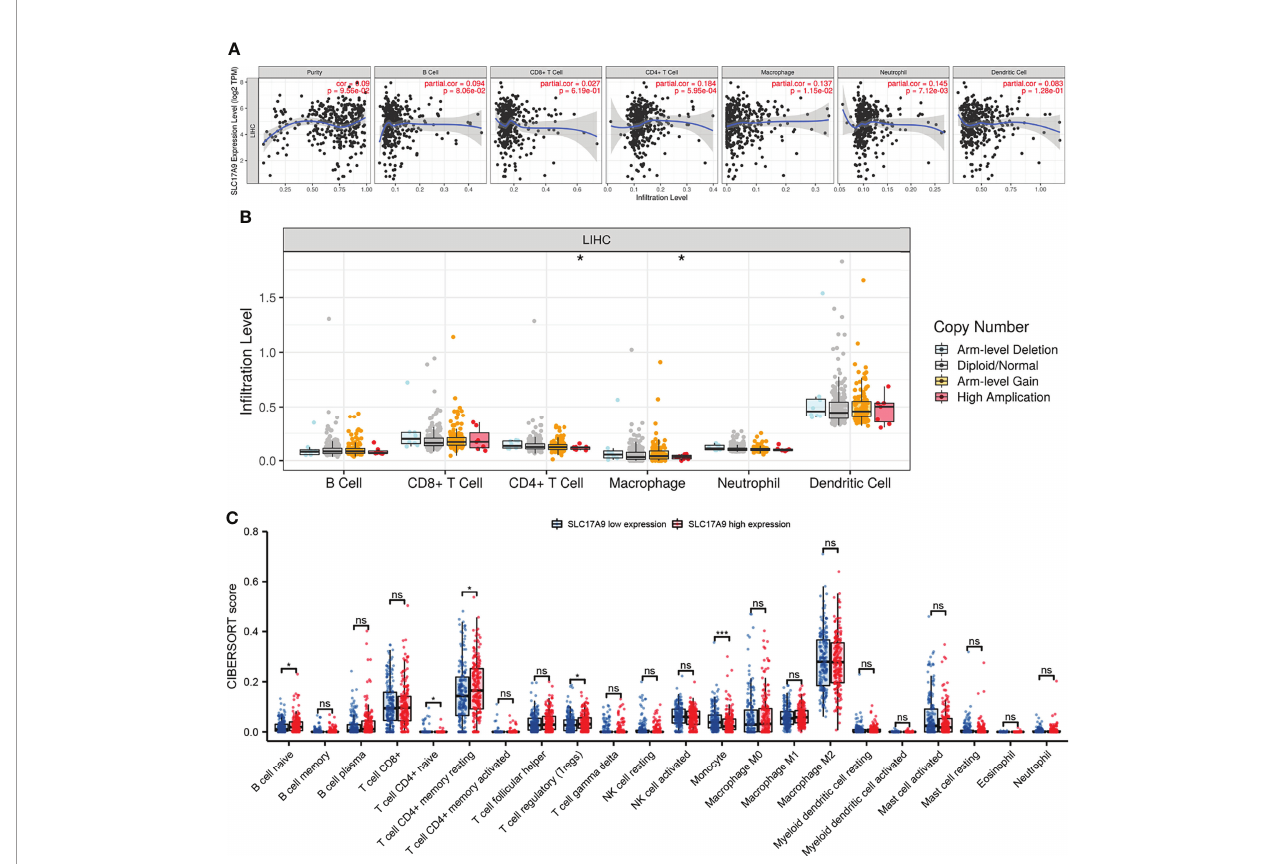
FIGURE 5 | Analysis of the correlation between SLC17A9 and immune cells and genetic copy number variations (CNV) of SLC17A9 with the relative abundance of tumor-in fi ltrating cells and CIBERSORT analysis. (A) Correlation between SLC17A9 and tumor immune in fi ltrating cells (B) SLC17A9 CNV affects the in fi ltrating levels of CD4 + T cell and neutrophil cells in LIHC. (C) The change ratio of 22 immune cell subtypes in the high and low SLC17A9 expression groups in LIHC. *p < 0.05; **p < 0.01; ***p < 0.001; ****p < 0.0001.